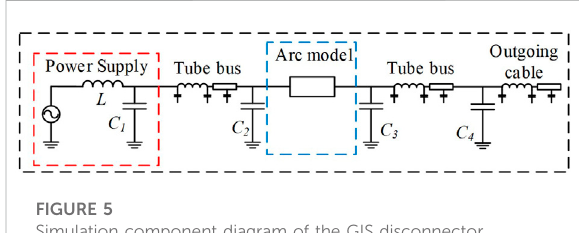
FIGURE 5 Simulation component diagram of the GIS disconnector breaking no-load line.